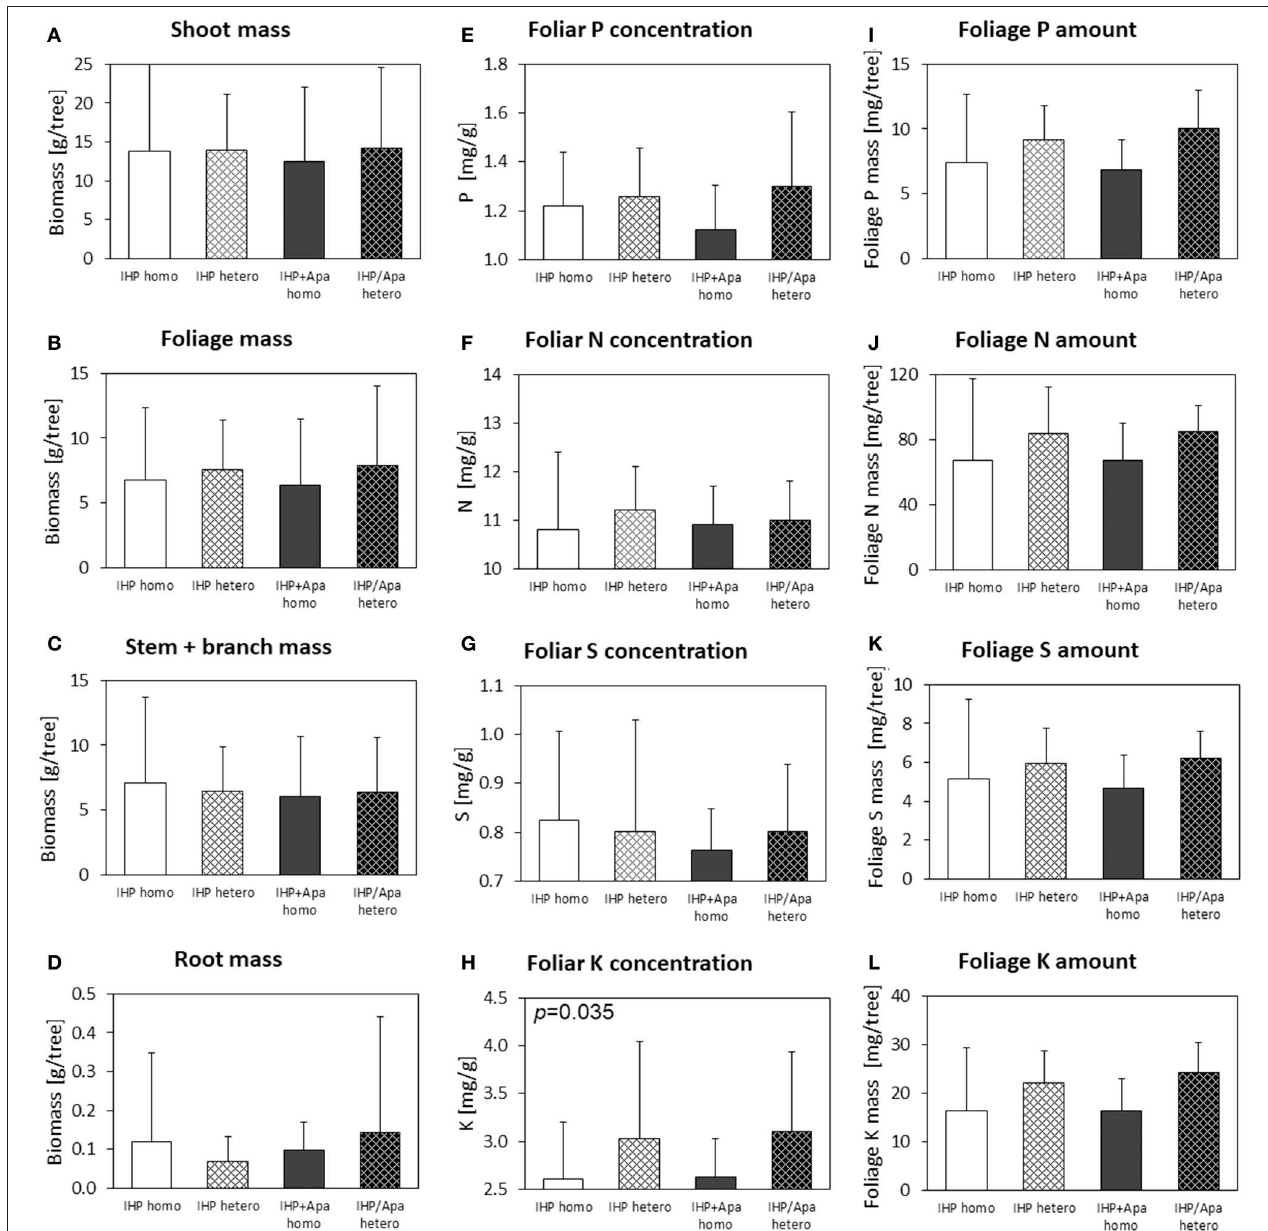
FIGURE 5 | Shoot (A) , foliage (B) , stem + branch (C) , and root (D) biomass, foliar concentrations of N (E) , P (F) , S (G) , and K (H) , and nutrient (P, N, S, K) amounts in foliage (I–L) of Picea abies with elevated N deposition at the low-P calcareous site. Numbers in the upper left panel corner show p < 0.1 for differences between mean values of homogeneous vs. heterogeneous P application calculated by one-way